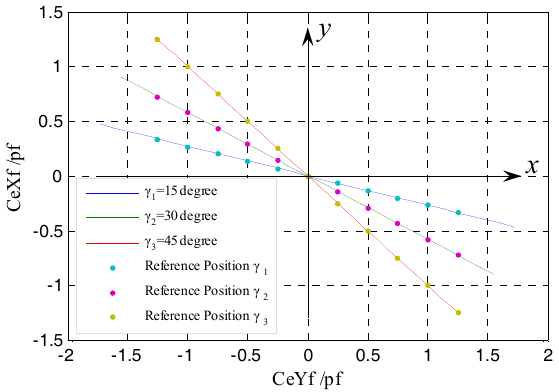
Figure 17. CeXf/CeYf under the different yaw angles.